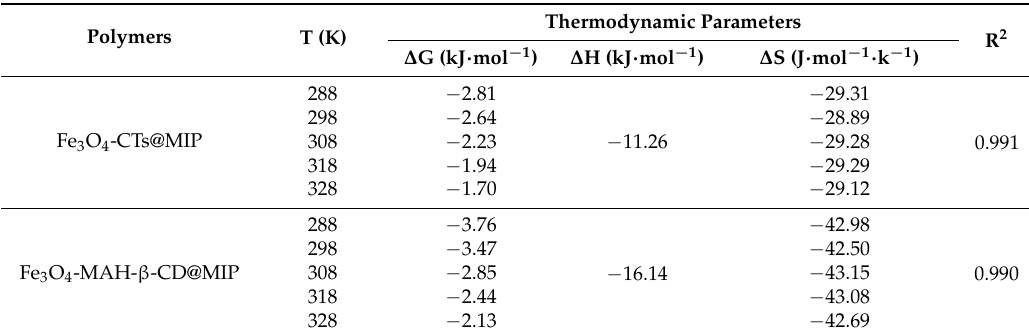
Table 5. Thermodynamic parameters for adsorption of 2-aminopyridine on Fe 3 O 4 -CTs@MIP and Fe 3 O 4 -MAH- β -CD@MIP at various